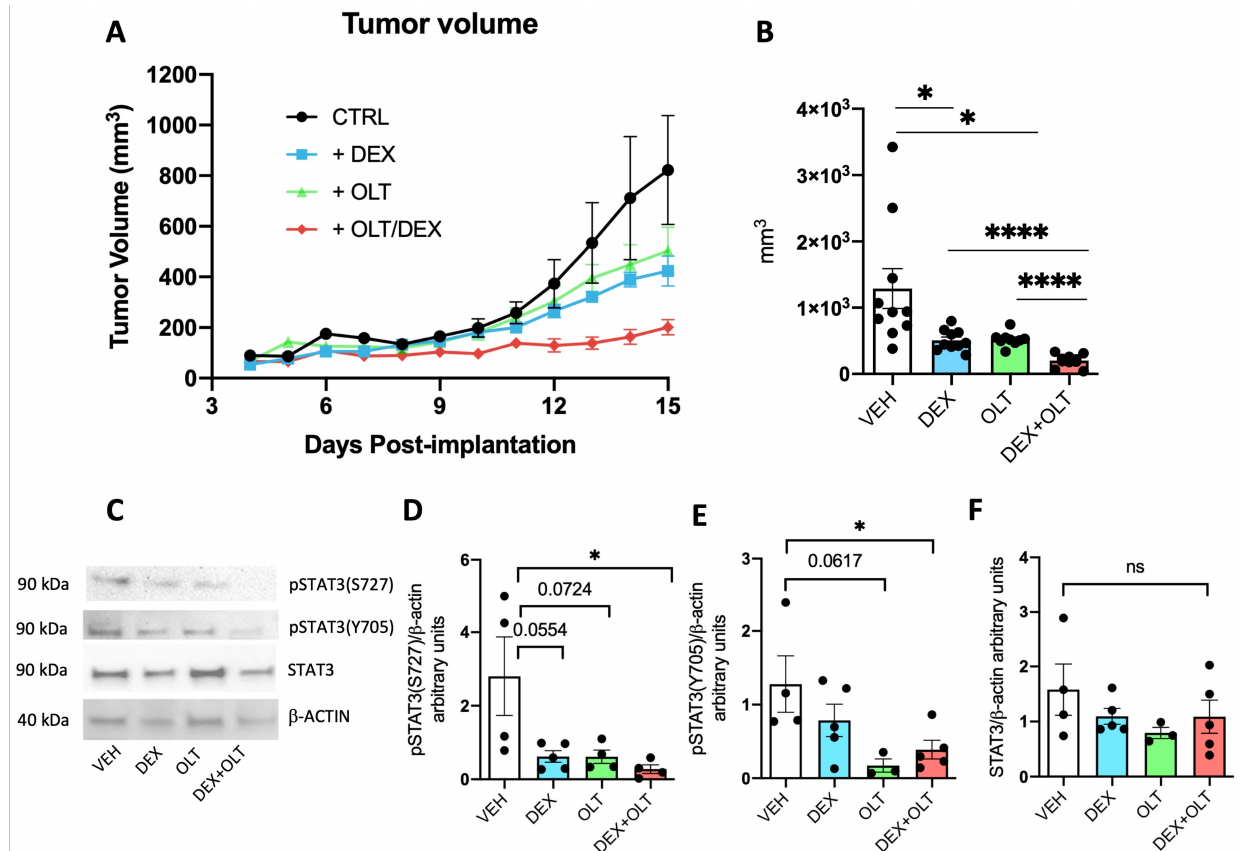
Figure 1. Inhibition of melanoma growth and STAT3 phosphorylations by OLT1177 and dexametha- sone. ( A ) Measurement of tumor growth from day 4 post-implantation to day 15. Tumors were measured every day with an electronic caliper. ( B ) Tumor volume on day 15 derived from data in A. ( C ) A representative Western blot performed on primary tumor samples. ( D ) Histogram derived from Western blot (shown in ( C )) of pSTAT3 (S727) levels in the primary tumor. ( E ) Histogram derived from Western blot (shown in ( C )) of pSTAT3 (Y705) levels in the primary tumor. ( F ) Histogram derived from Western blot (shown in ( C )) of total STAT3 levels in the primary tumor. The data are presented as mean ± SEM. * p < 0.05; **** p < 0.0001; ns = not